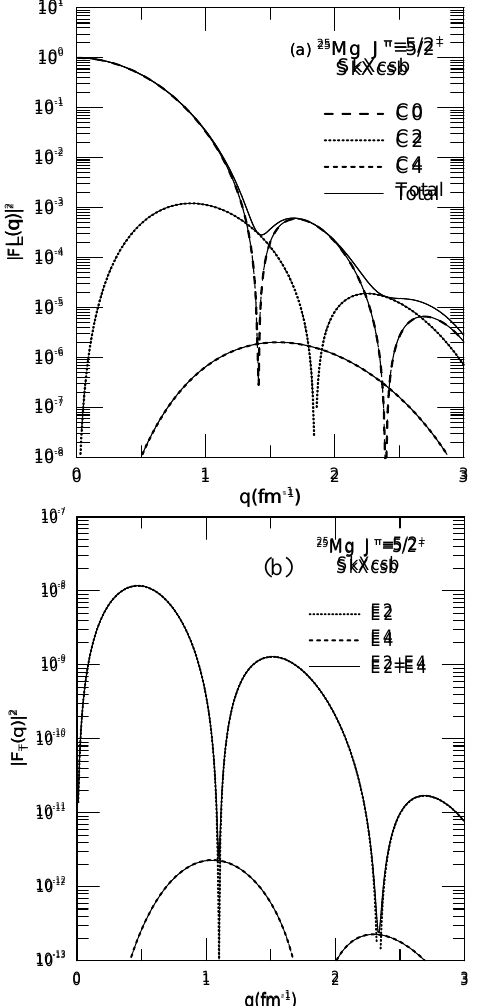
Fig. 2: Theoretical longitudinal (a) and transverse (b) form factors for 25 Mg in 5/2 + state using SkXcsb parameterization.